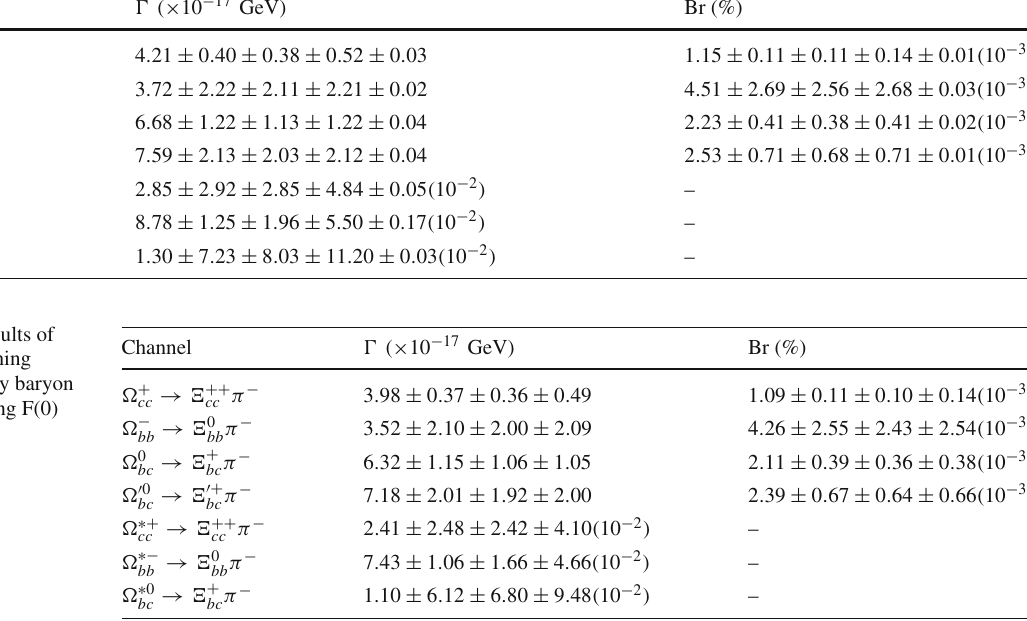
Table 8 Numerical results of decay width and branching fraction in doubly heavy baryon nonleptonic decays using F( q 2 ) Channel